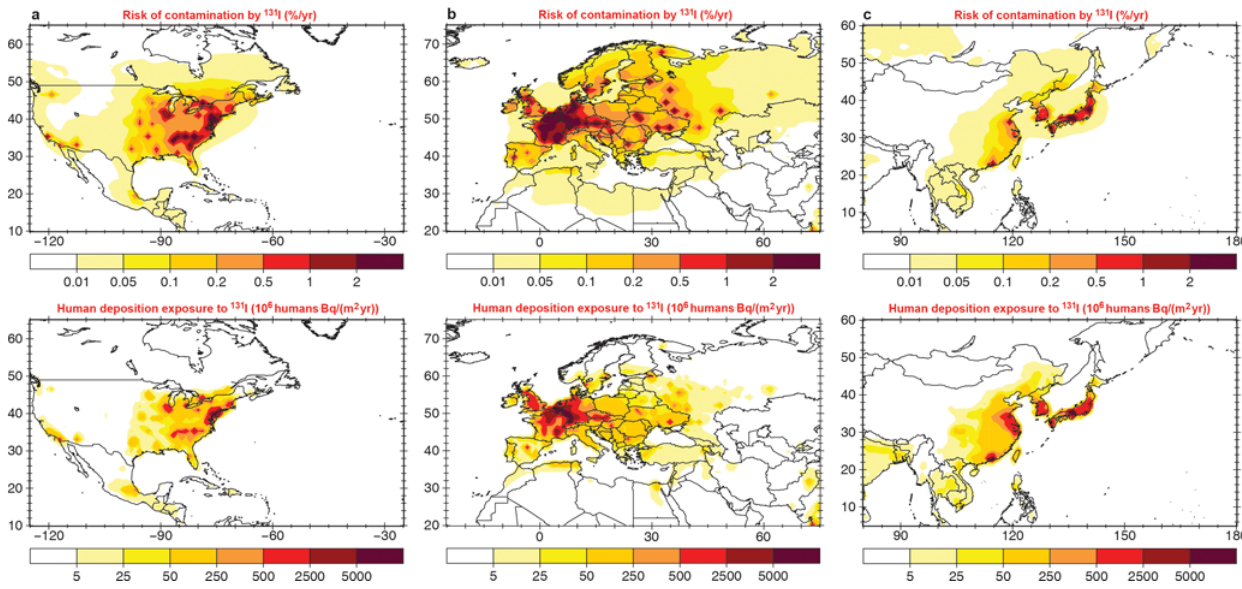
Fig. 5. Regional risks of radioactive contamination by 131 I. Same as Fig. 4 for selected